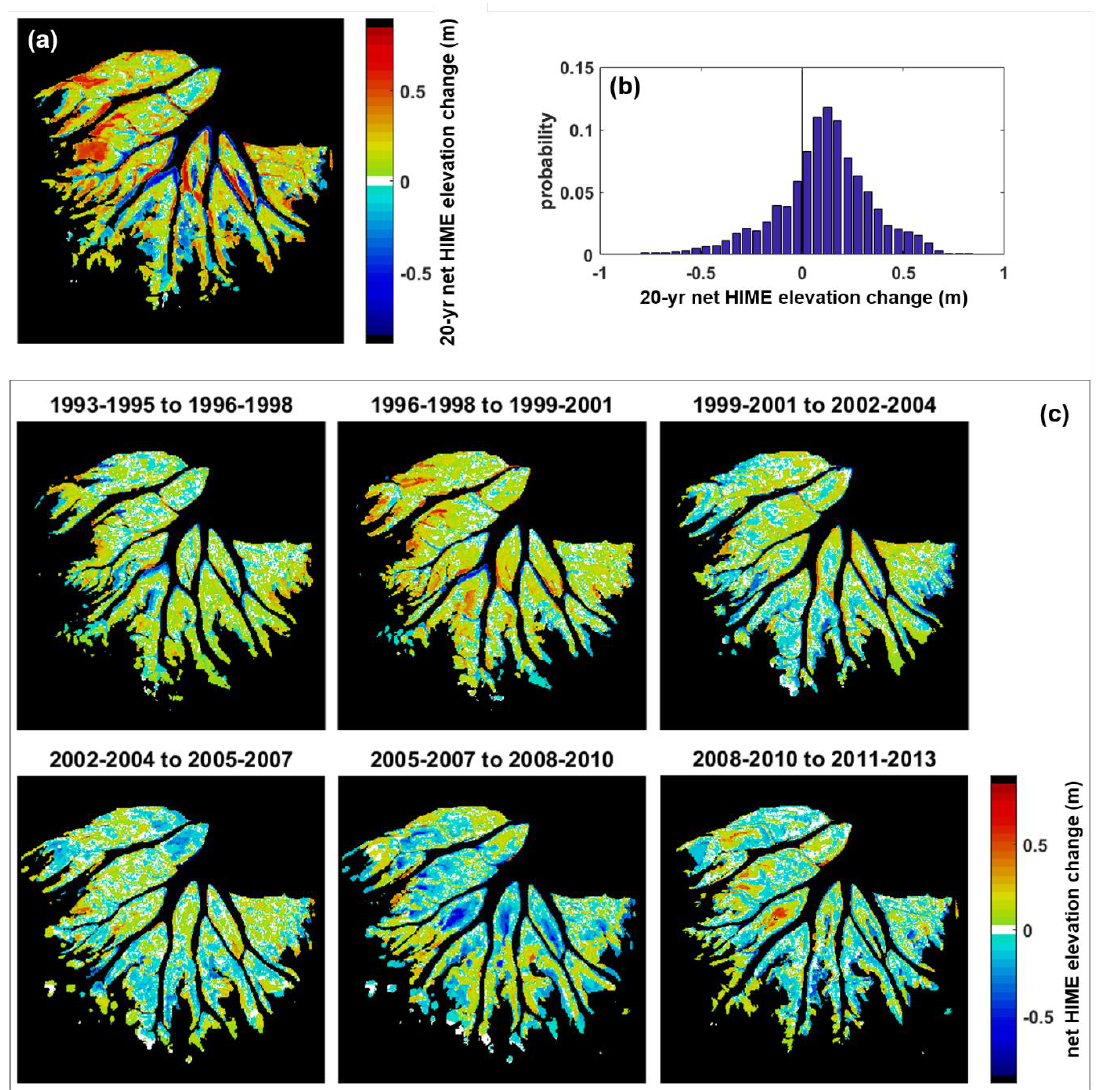
Figure 7. ( a ) Map of net marsh top elevation change over the study period, from 1993–1995 to 2011–2013. ( b ) Distribution of probabilities of net HIME marsh top elevation change over the study period. ( c ) Maps of net estimated marsh top elevation change between consecutive timeframes; net aggradation in green-yellow-red, net erosion in light blue-dark blue.